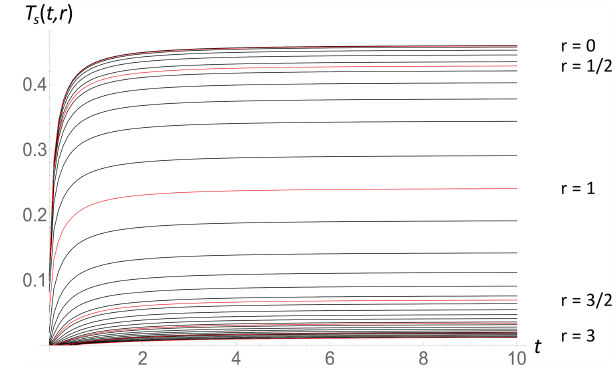
Figure 5. The response to a unit intensity forcing in the unit circle. The temperature as a function of nondimensional time is given for different distances from the center: top ( r = 0) to bottom ( r = 3) from the same data as before: red every 1 / 2 and black every 0.1 (top r = 0; bottom r = 3).